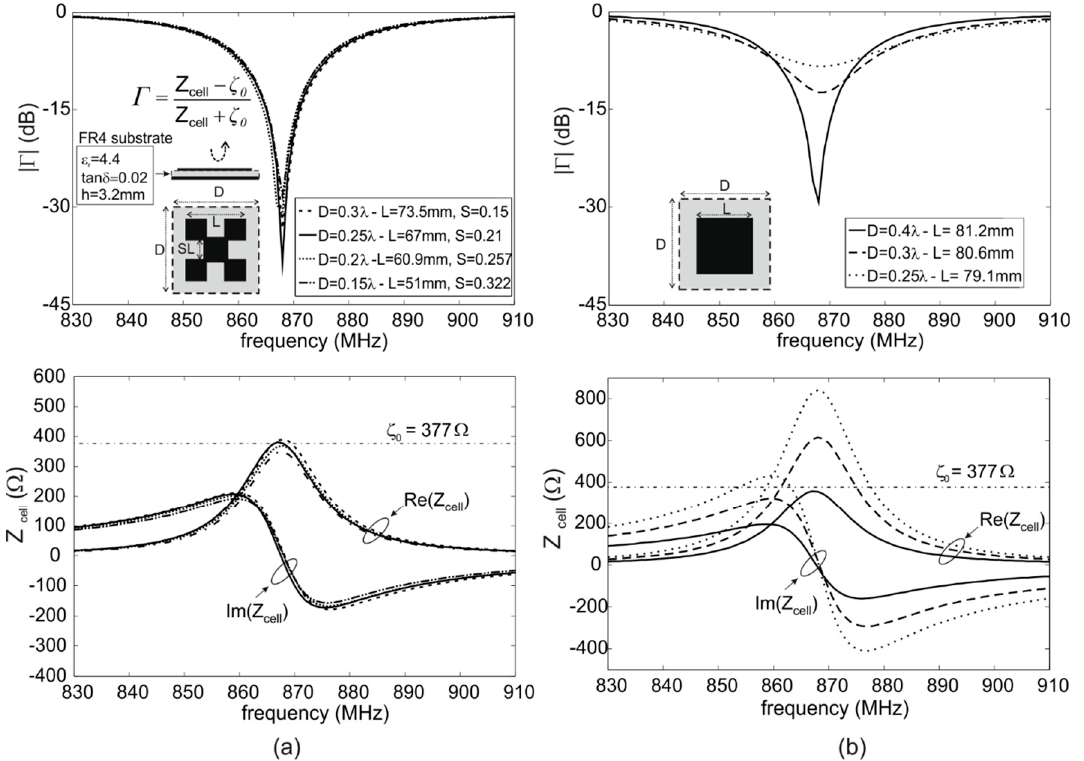
Figure 2. Reflection coefficient and unit cell input impedance vs. frequency for different cell sizes D: ( a ) fractal-based cell; ( b ) square-based cell. ( a ) fractal-based cell; ( b ) square-based cell.